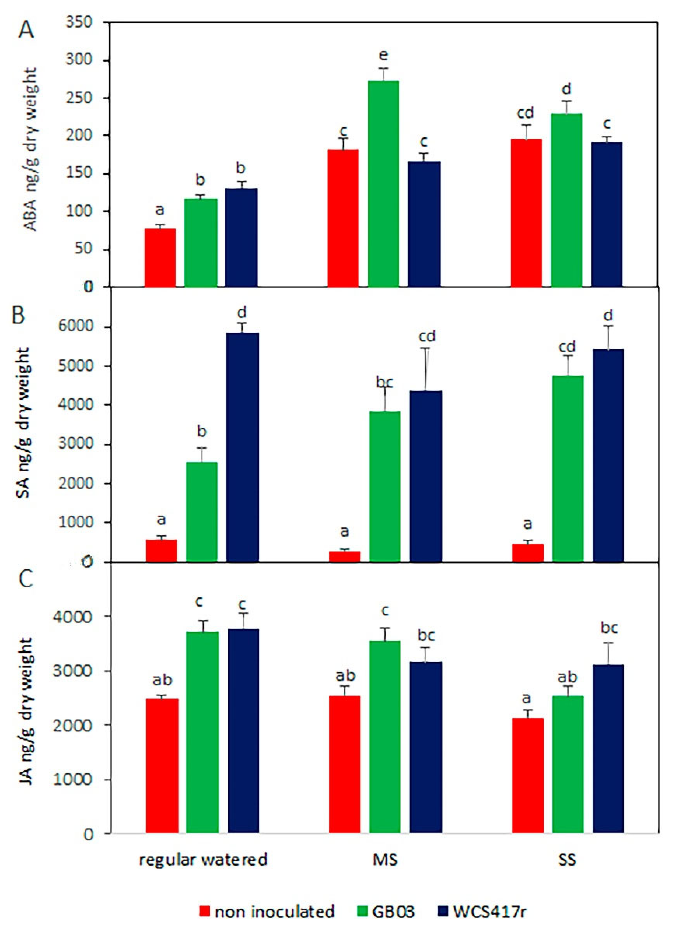
Figure 3. Endogenous plant hormone level ( A ) abscisic acid (ABA) ( B ) salicylic acid (SA) ( C ) jasmonic acid (JA) in peppermint plants inoculated with PGPR strains subjected to moderate (MS) or severe drought stress (SS). Different letters indicate significant differences between treatments based on Fisher’s LSD test (n = 15–20, p < 0.05).